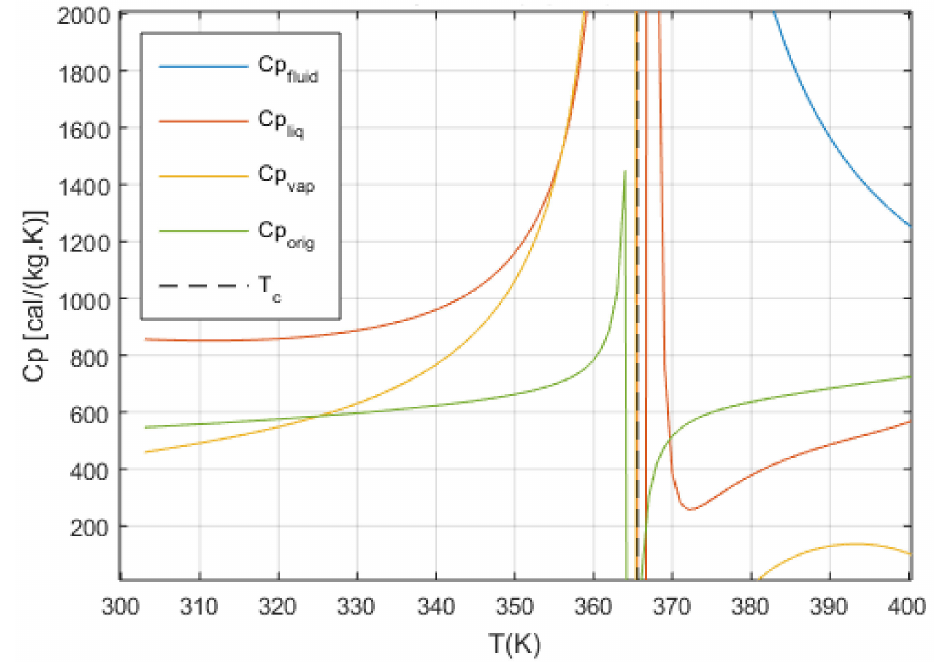
Figure 10. Comparison of heat capacity near the critical temperature.